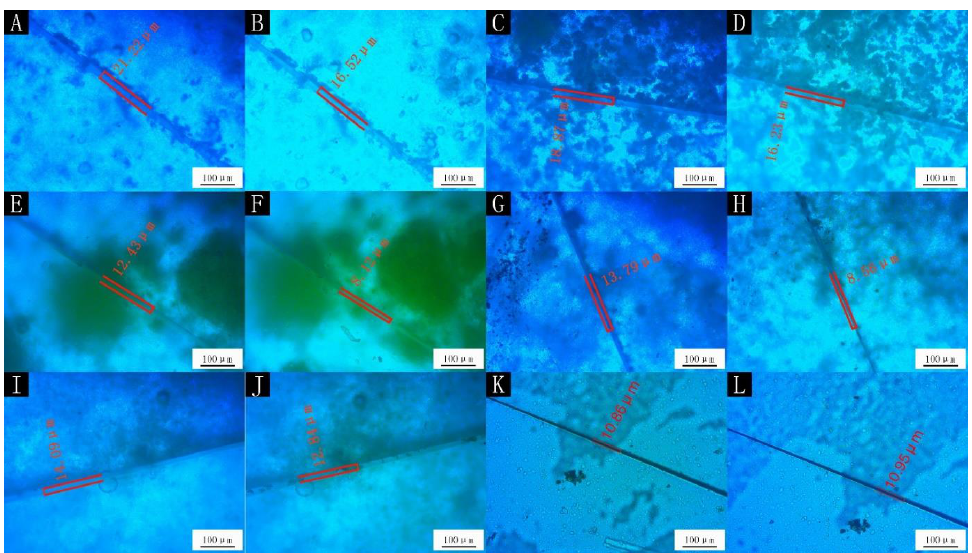
Figure 10. Micrographs of paint film self-healing test of five emulsifier microcapsules: ( A ) the first day of Span-80, ( B ) the fifth day of Span-80, ( C ) the first day of SDBS, ( D ) the fifth day of SDBS, ( E )